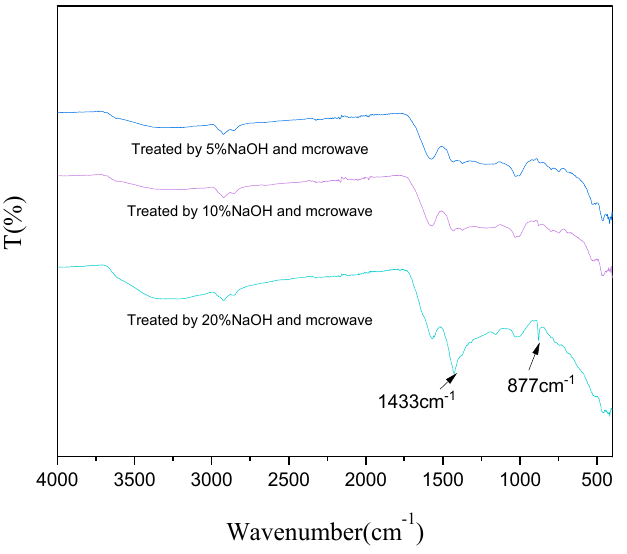
Figure 5. FTIR curves of coal sample treated by microwave combined with different concentration of sodium hydroxide solution.